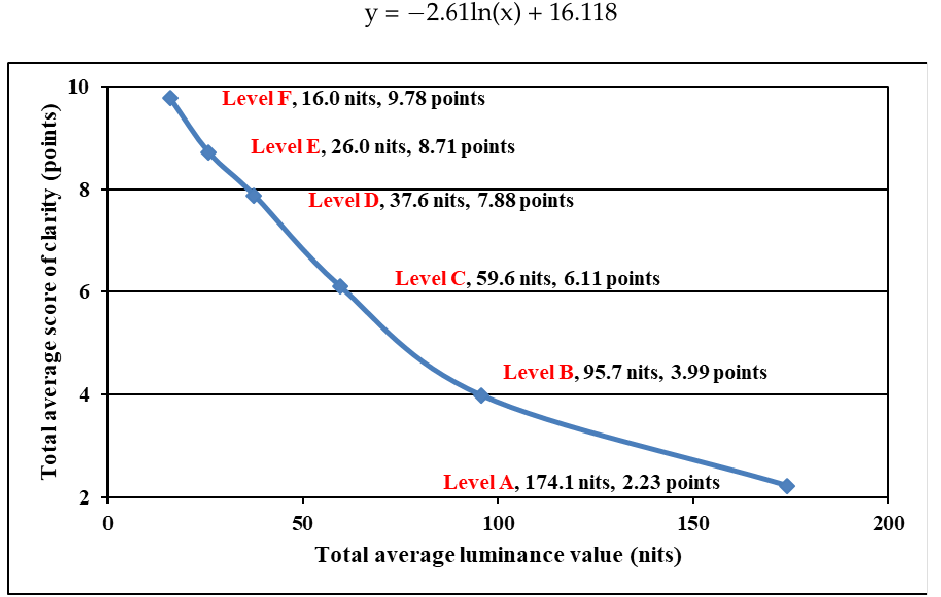
Figure 8. The relationship trend and formula between visual clarity and average luminance of the screen.